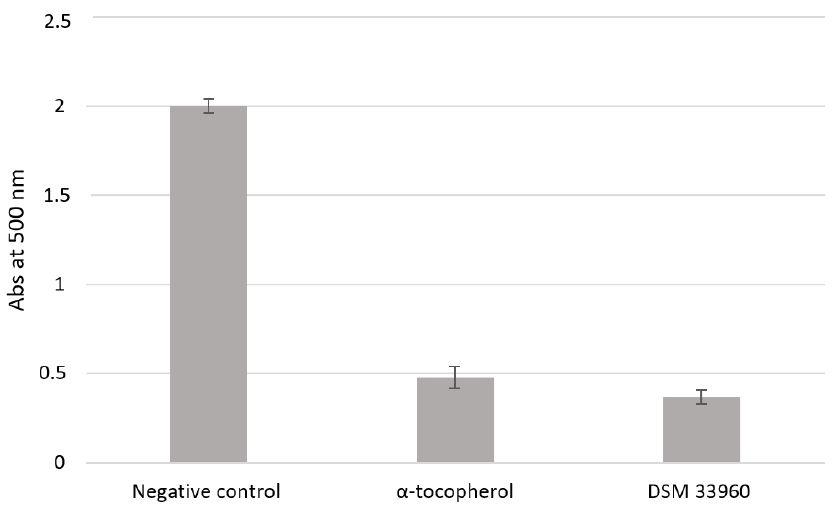
Figure 2. Lipid peroxidation inhibitory activity of the L. rhamnsous CA15 (DSM 33960) strain.